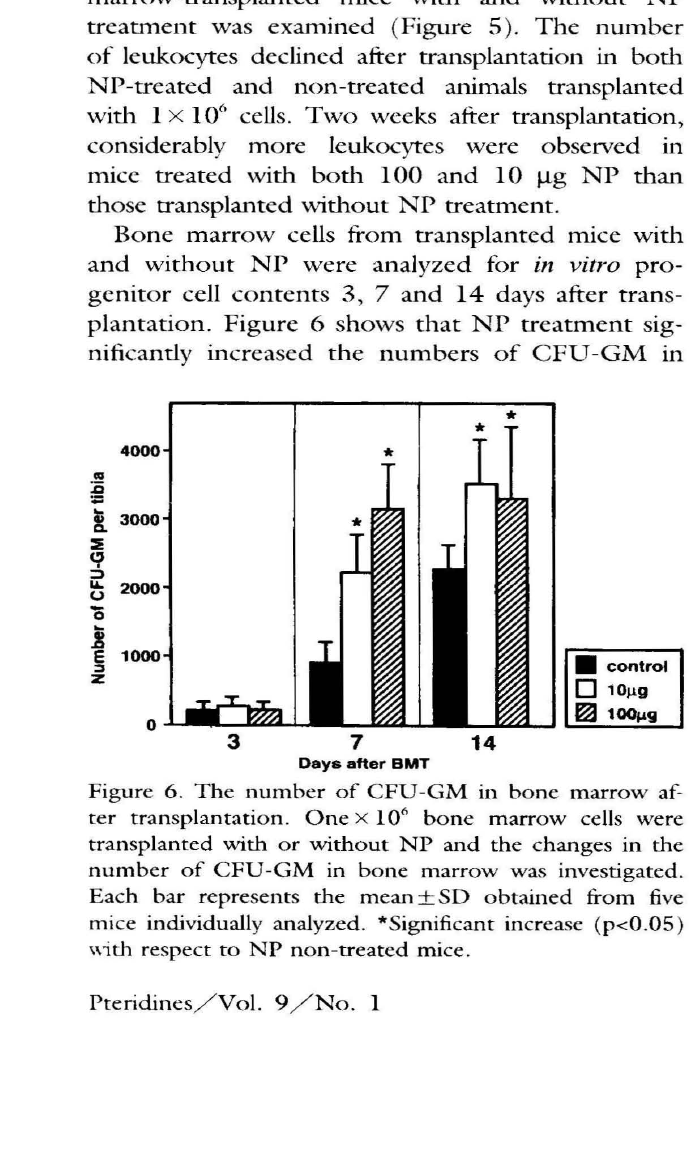
those transplanted without NP treatment.